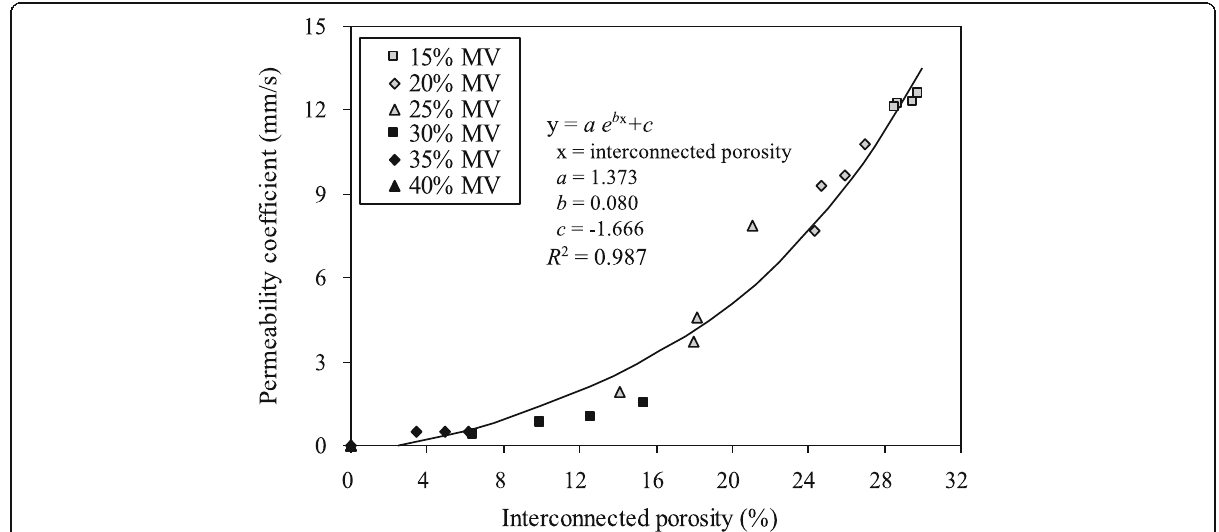
Fig. 10 Effect of interconnected porosity on unsubmerged permeability